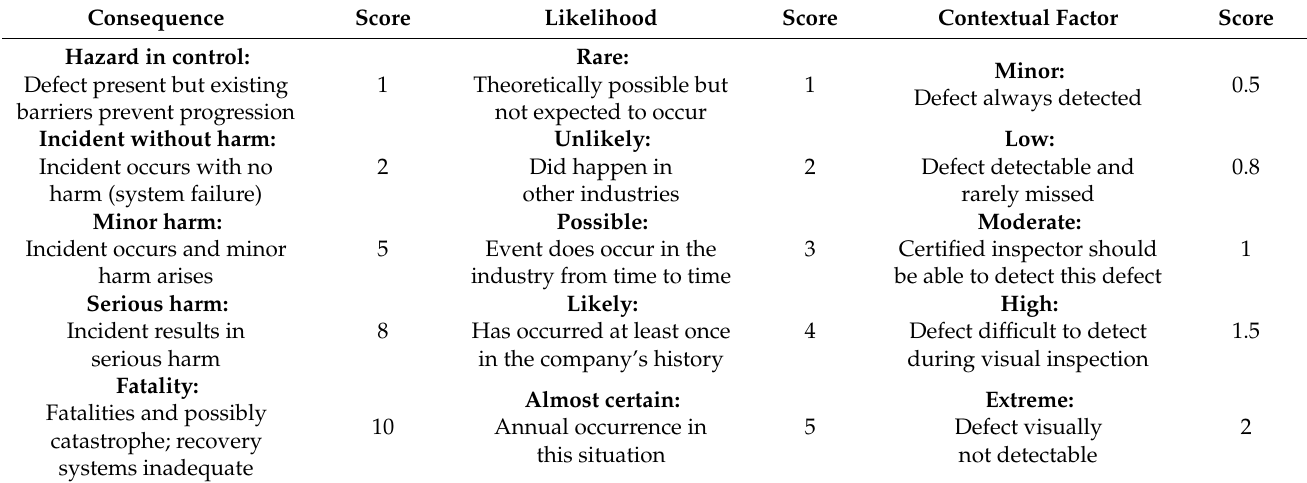
Table 3. Proposed risk factor scales for an inspection process.